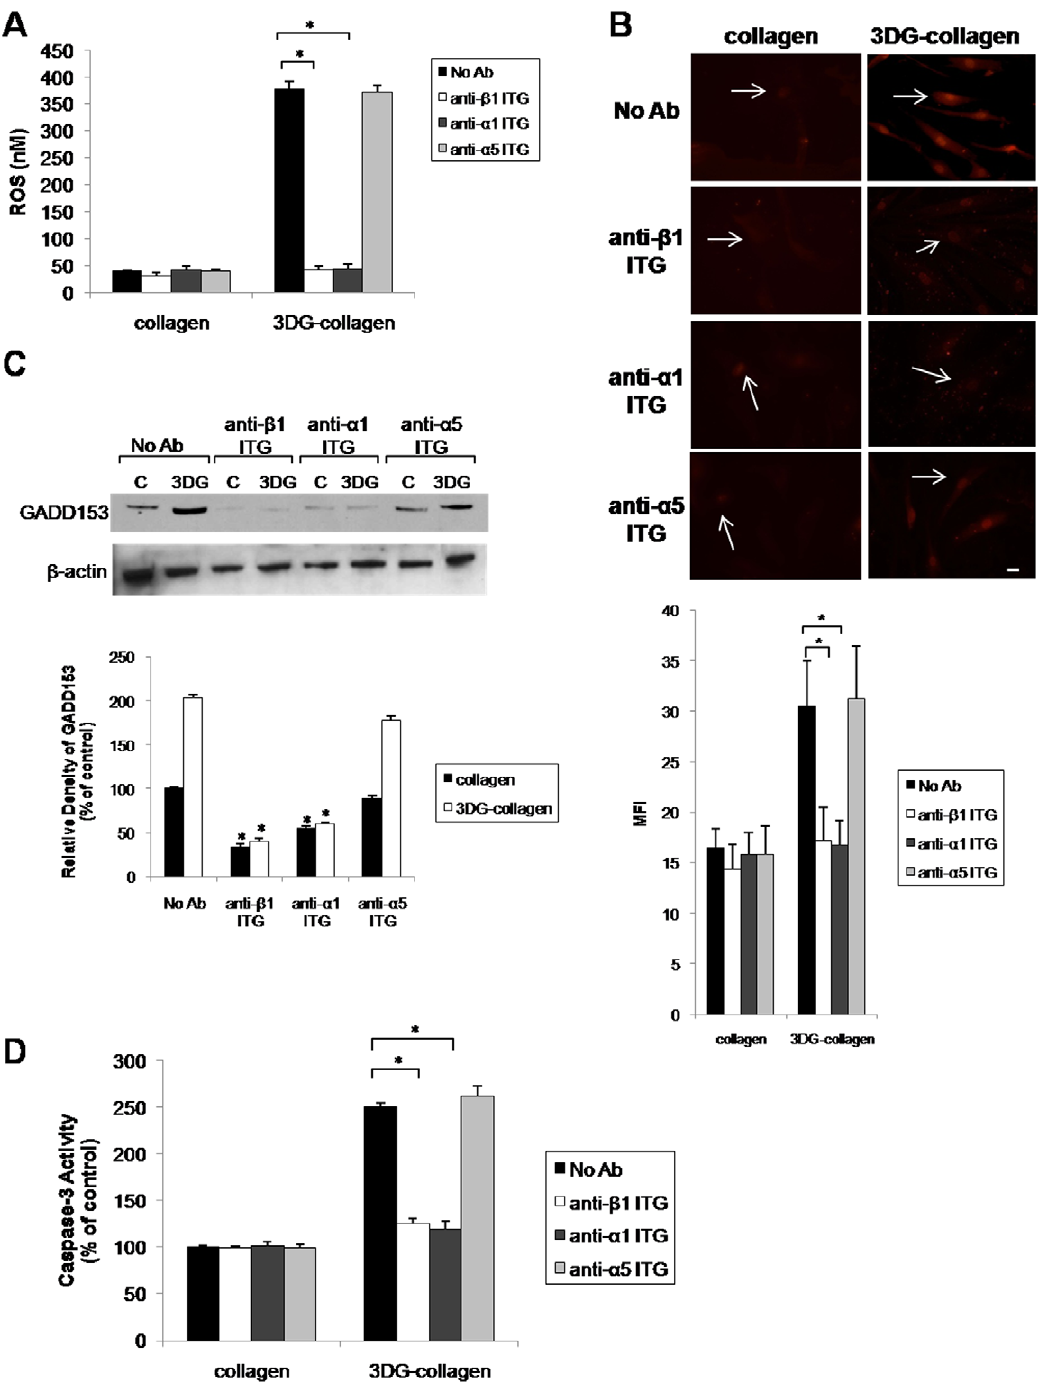
Figure 10. Effect of neutralization of a 1 b 1 integrin on 3 DG-collagen-induced ER stress pathway. A , Fibroblasts were pretreated with or without the blocking antibodies anti- b 1 ITG, anti- a 1 ITG, and anti- a 5 ITG (10 m g/ m L) for 30 min and cultured on native collagen, or 1 mM 3 DG- collagen, for 24 h and analyzed for the production of ROS. Fibroblasts were incubated with DCFH-DA for 30 min and the level of intracellular ROS was determined by measuring the fluorescence at 480 nm/530 nm. B , GADD153 localization in the nucleus was analyzed by immunofluorescence using a Cy3-conjugated secondary antibody. Images were taken at 40 6 magnification on an epi-fluorescence microscope and the MFI of ten nuclei was processed by ImageJ. Arrows indicate nuclei containing GADD153. Scale bar represents 10 m m. C , Western blot of GADD153 expression after neutralization of b 1, a 1, and a 5 integrins. The bars correspond to the densitometric value of GADD153 after normalization for b -actin. D , Caspase-3 activity detected using the Caspase-3 Colorimetric Correlate Assay. All comparisons are made against collagen treated with PBS unless otherwise indicated. Data are mean 6 SD (n=3), *P , 0.001.